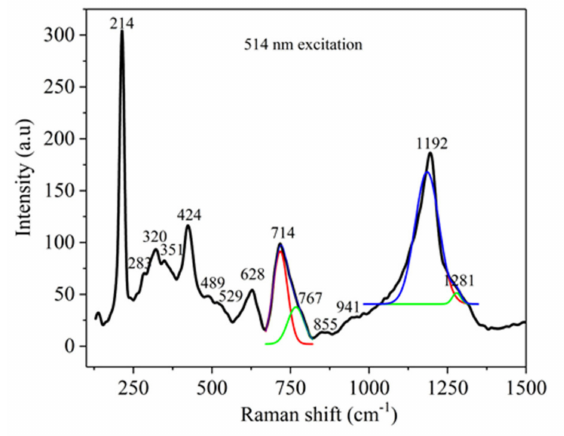
Figure 7. Raman spectrum of the Te-5 glass